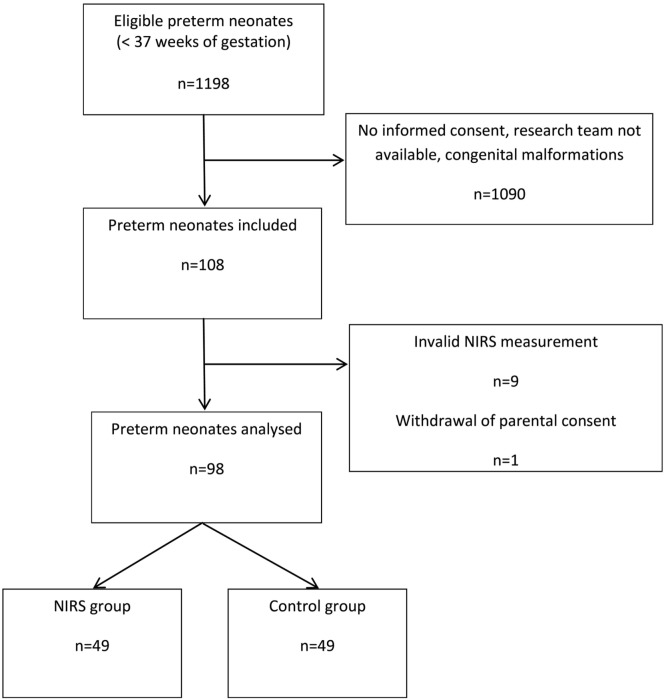
Flow diagram showing the number of included neonates and rationales for exclusion.